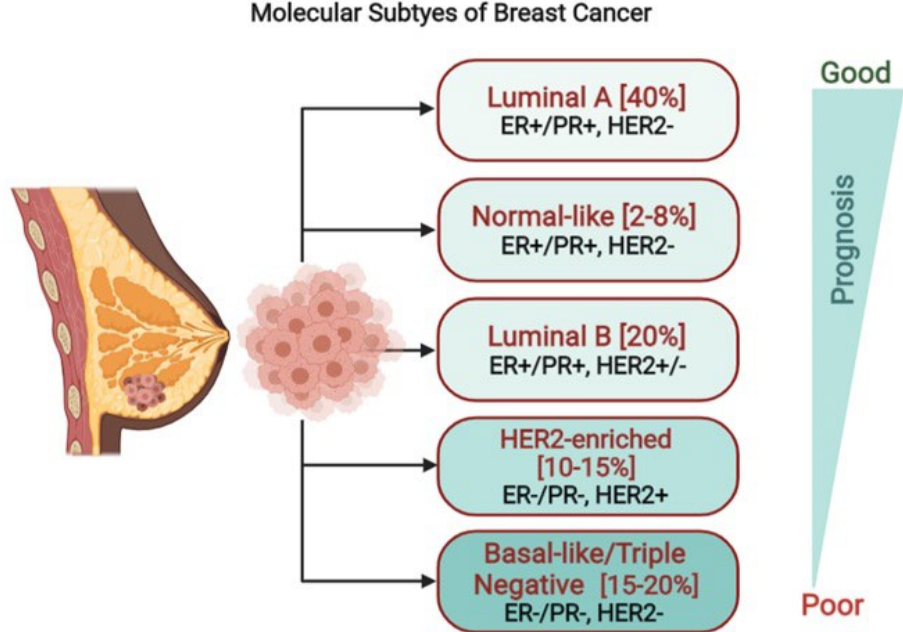
Figure 1. Molecular subtypes of breast cancer. Breast cancer can be categorized five different subtypes based on their expression of hormone receptors [estrogen receptor (ER) and progesterone receptor (PR)], and the HER2 overexpression. Prognosis varies based on the subtype of breast cancer where the triple negative cancer has worst prognosis and luminal A cancer has best prognosis. Targeted therapies, such as herceptin (aimed at the HER2 protein) and tamoxifen (aimed at the ER), can be used in the treatment of certain breast cancer subtypes. This image was created using Biorender software.